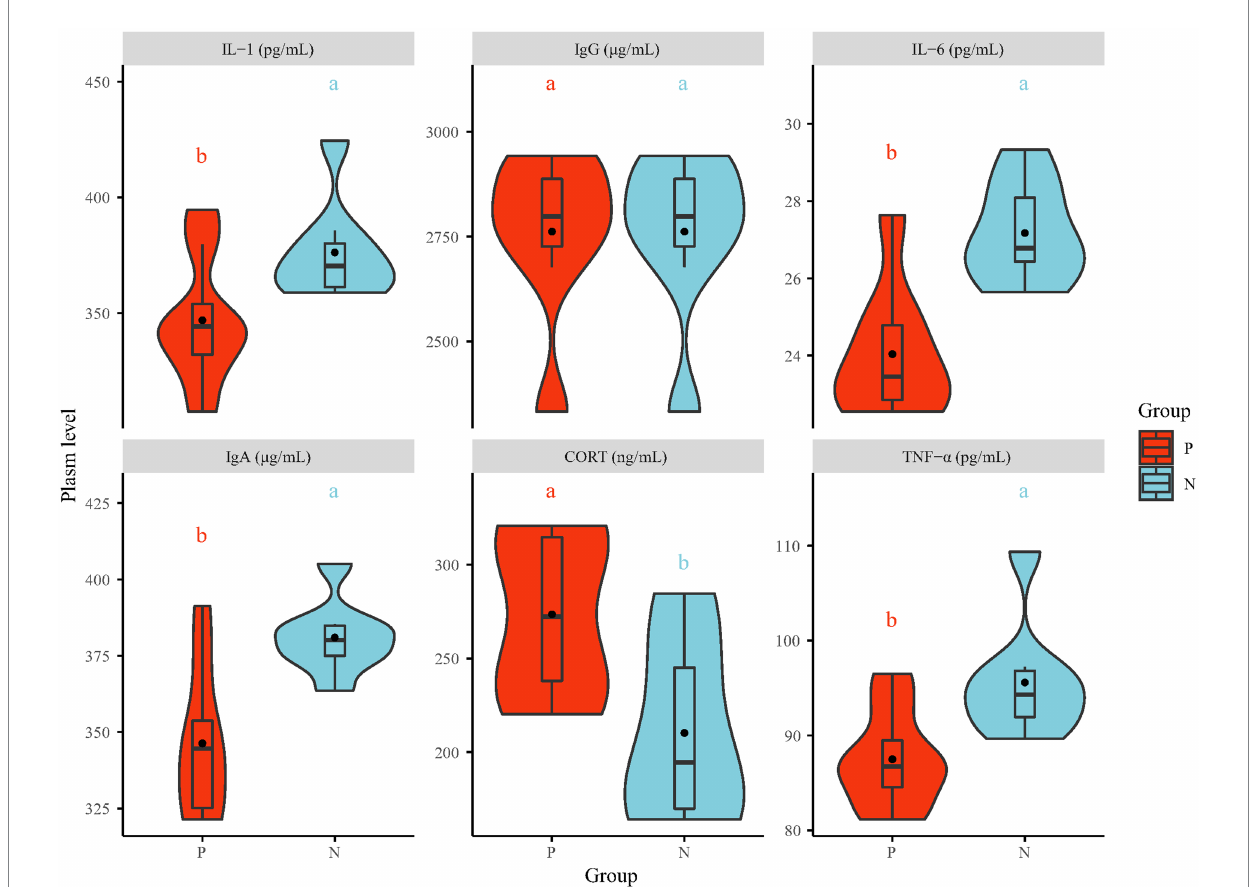
FIGURE 2 The plasma level of stress (CORT) and immune indices (IgA, IgG, IL-1, IL-6 and TNF- α ). IgA = Immunoglobulin A, IgG = Immunoglobulin G, IL-1 = interleukin-1, IL-6 = interleukin-6, TNF- α = tumor necrosis factor- α , CORT = corticosterone. The values in the violin plot are the means ± SE ( n = 8). The statistically significant differences between the P and the N group are indicated as different letter (a, b; p < 0.05). P = feather pecker, N =